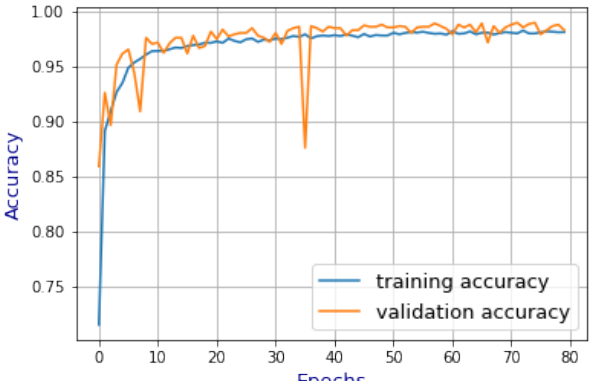
Figure 9. Behaviour of the accuracy metric over the epochs in the training and validation sets. It can be noticed that in both curves the accuracy is very similar and high; therefore, the ANN was well trained.